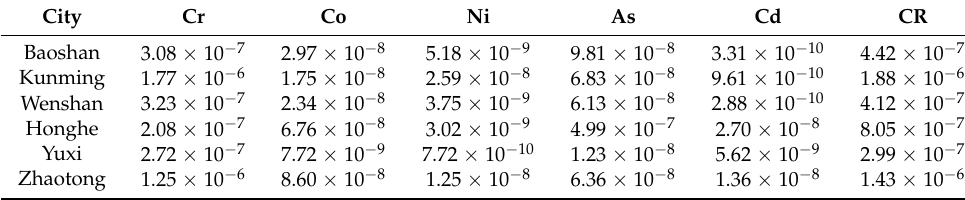
Table 6. Carcinogenic risk of potentially toxic elements in PM 2.5 of soil fugitive dust. City Cr